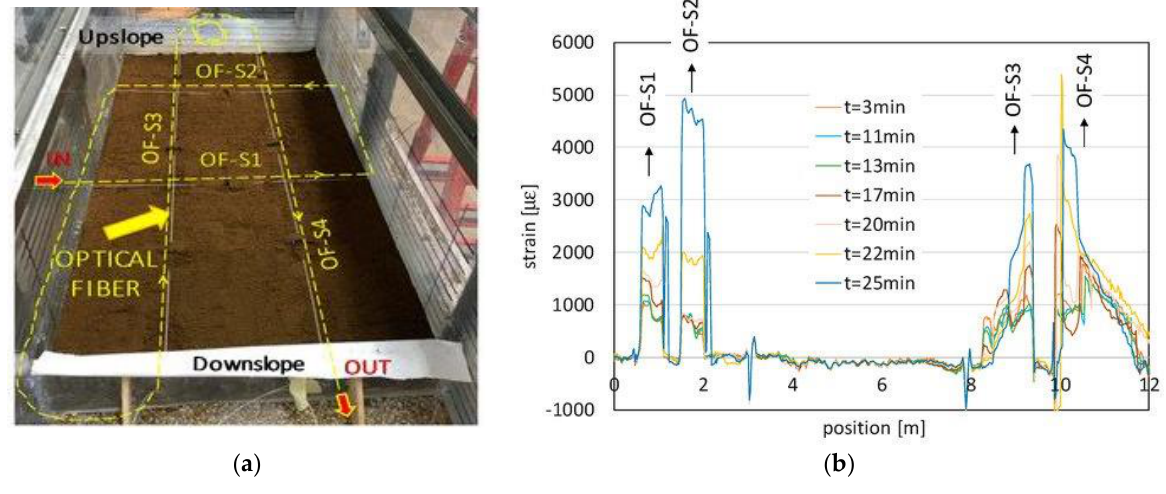
Figure 8. ( a ) Fiber installation during the reconstitution of the slope; ( b ) Strain trends measured by the optical fiber sensor (from Ref. [65]).